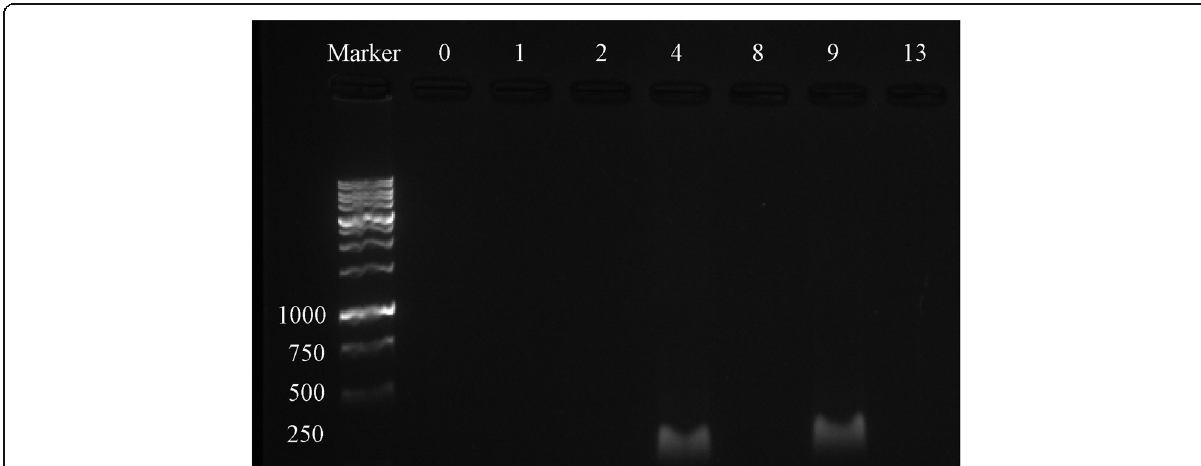
Fig. 4 Amplification of a 251-bp fragment on 1.5% agarose gel. Lane marker, molecular weight marker and lanes 0 – 13, and 4 μ l of bone from